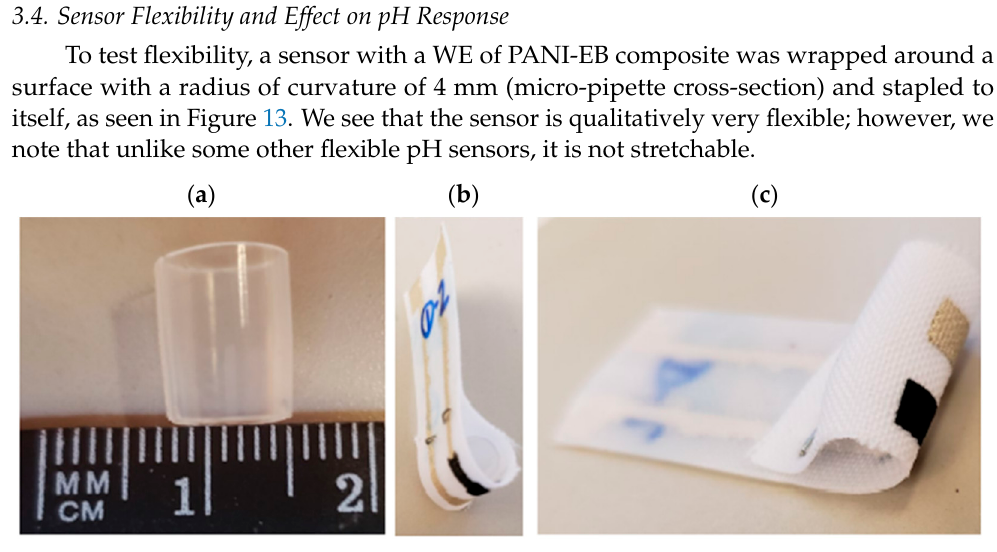
Figure 13. ( a ) Cross-section of disposable 5 mL plastic pipette used for setting radius of curvature of textile SPEs for flexibility testing; ( b , c ) Bent textile SPE with PANI composite WE and screen-printed Ag/AgCl RE.